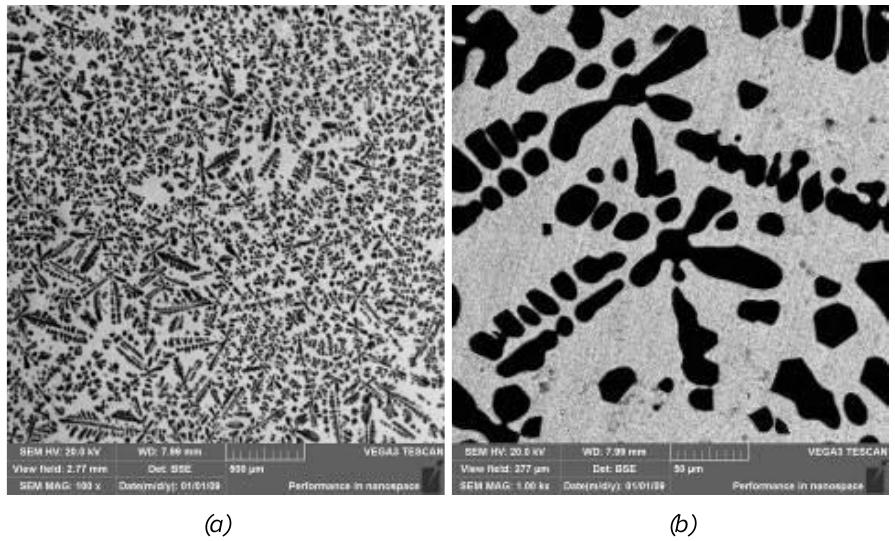
Fig. 4. SEM image of the Bi 54.6 Cu 45.4 alloy: (a) magnification 100X; (b) magnification 1000X.